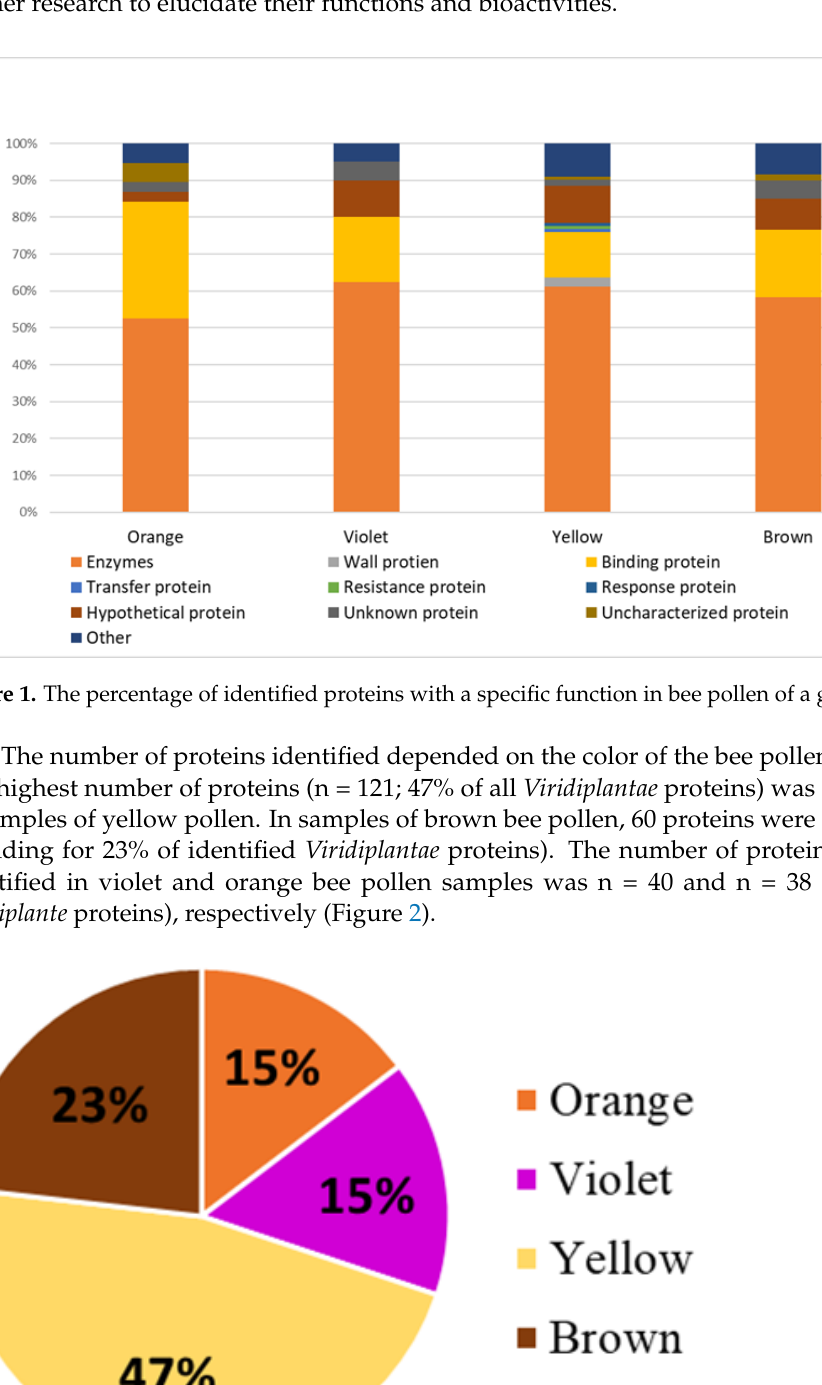
Figure 2. Numbers of proteins identified based on three or more peptides in bee pollen according to their color.